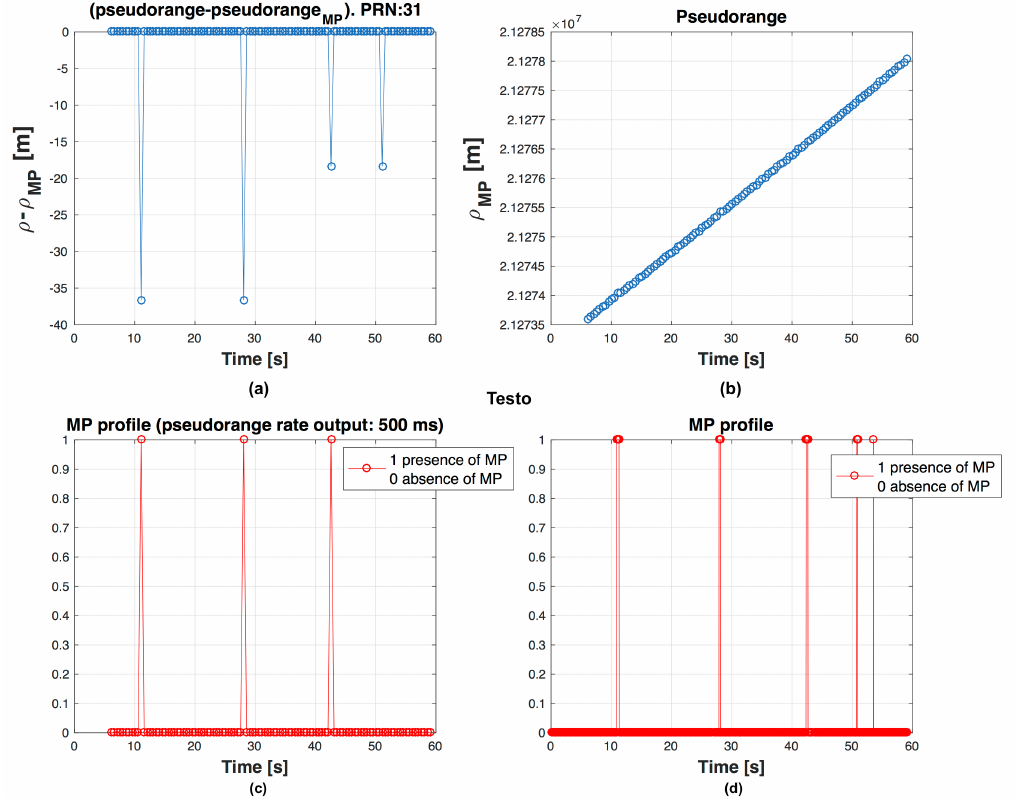
Figure 4. Behaviour of PR for PRN 31, with output every ∆ T ρ = 500 ms. PR error ( ρ clean − ρ MP ) ( a ); ρ MP trend in time ( b ); MP presence during a PR computation ( c ) and MP profile ( d ) are